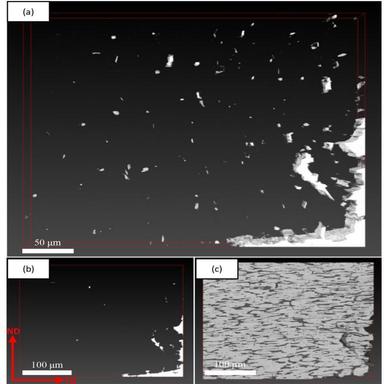
(a) 3D reconstruction of R87 TD-ND specimen showing microcracks, in white, near the fracture plane. (b) The bottom slice of microcrack reconstruction in (a) representing ~25 μm into the sample interior. (c) 3D reconstruction of the same region in (a) showing W (light) and Ni-Fe-W (dark) phases at the sample surface.